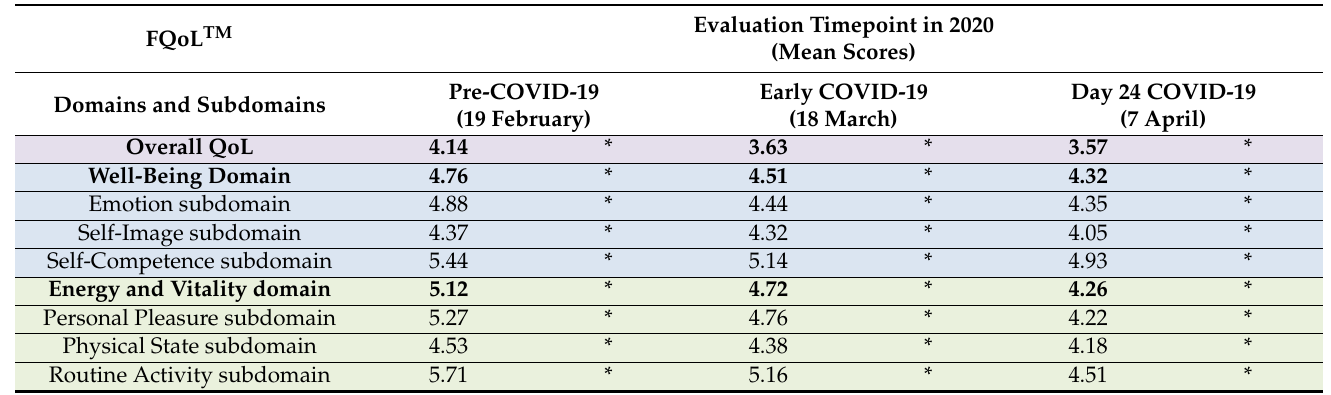
Table 5. Quality of Life Pre- and Post-COVID Stay-At-Home